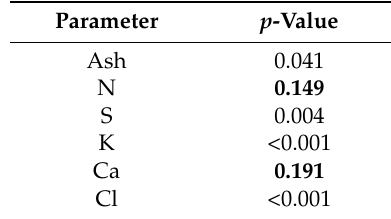
Table 1. Experiment 1: p -values of the Wilcoxon Test for differences in ash, N, S, K, Ca and Cl concentrations in press cakes due to the application of leaching step. Significant values ( p < 0.05) are in bold letters.